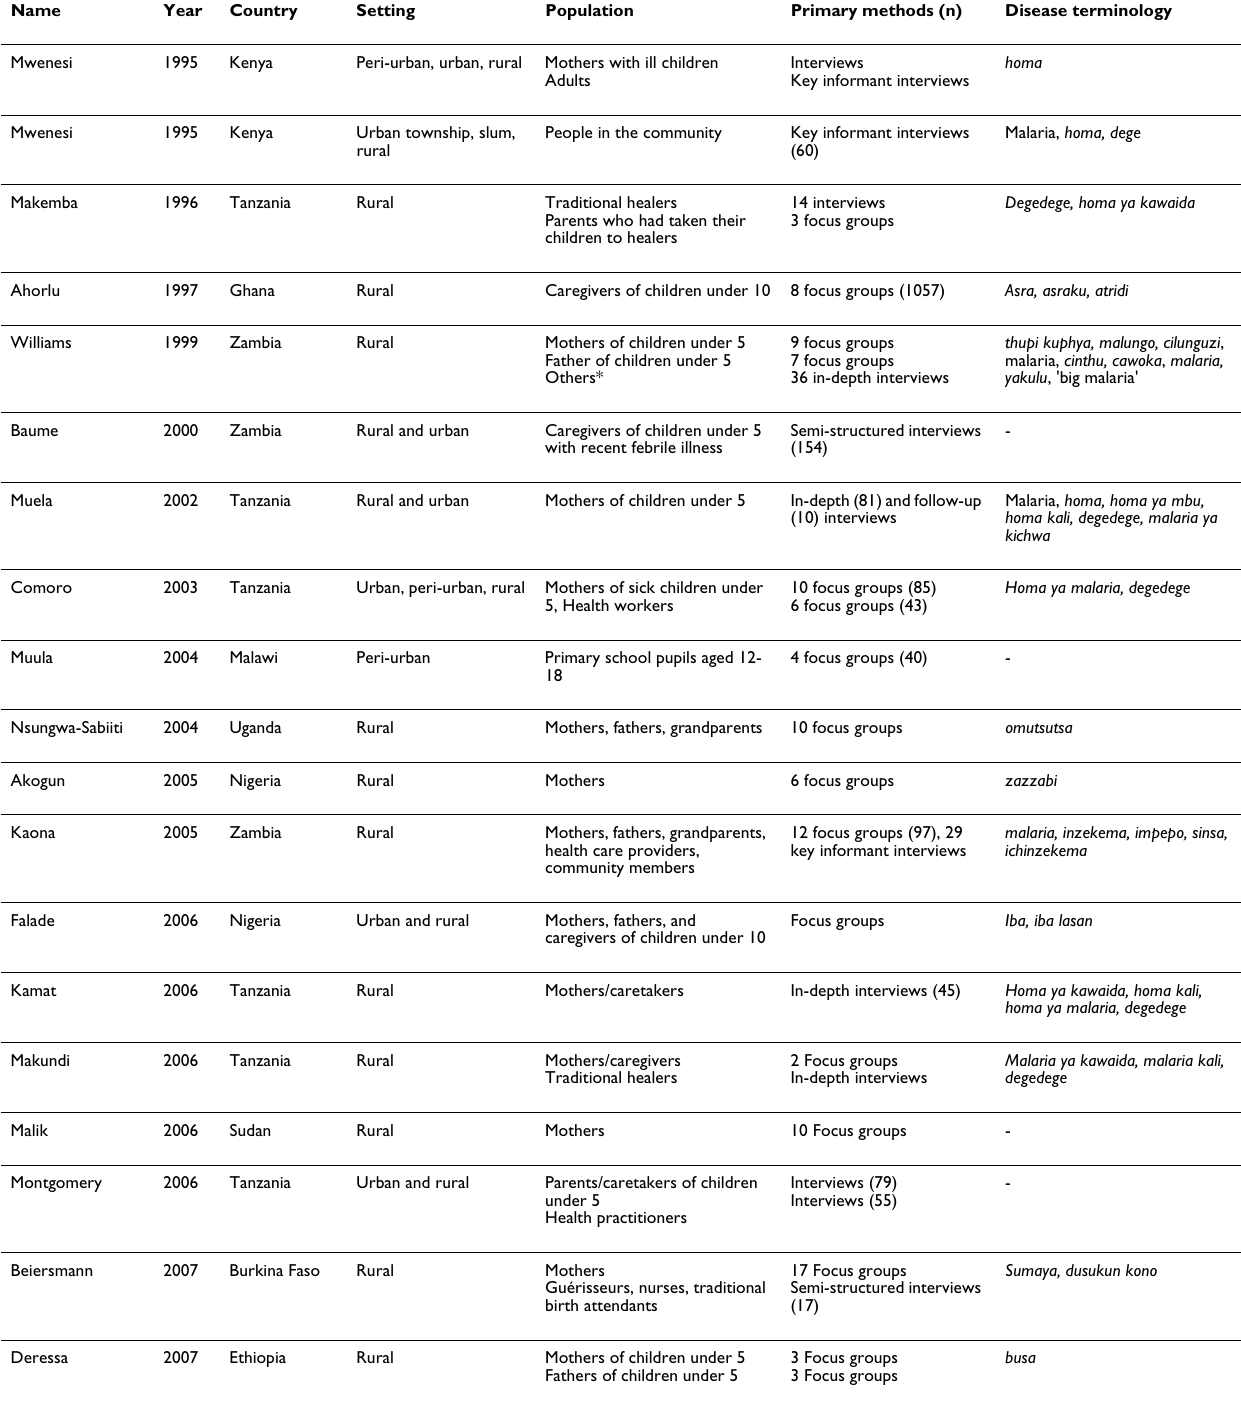
Table 1: Characteristics of qualitative studies in children